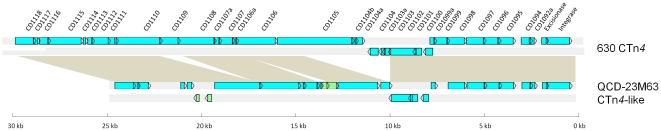
Schematic representation of the CTn4-like element in QCD-23M63.Blue ORFs are present in strain 630 CTn4, green ORFs are not present in CTn4. Brown boxes show regions of homology.